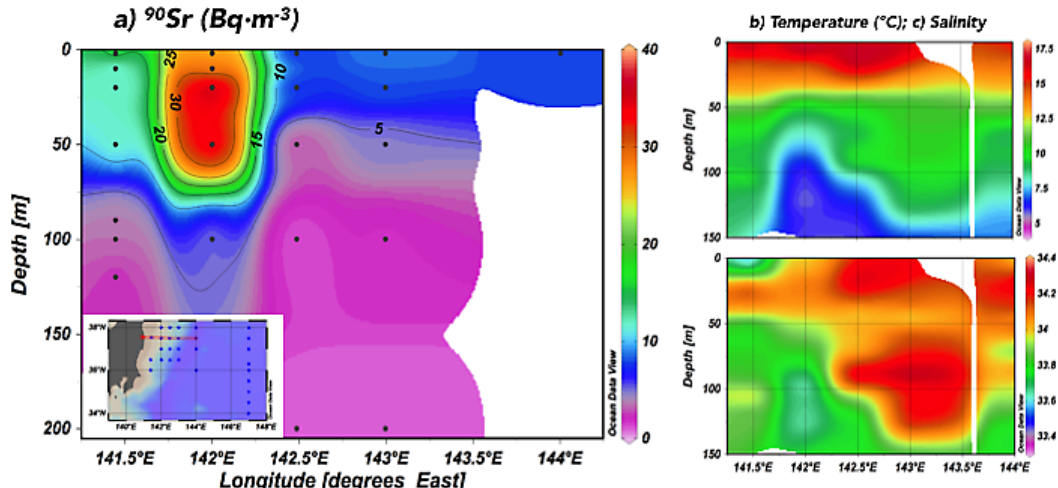
Fig. 4. (a) Specific activities of 90 Sr (expressed in Bqm − 3 ) and (b) temperature and (c) salinity contour plots in a section at Fukushima NPP latitude. It comprises stations 25 (left, closest to Fukushima), 23, 21, 19 and 11 (right).